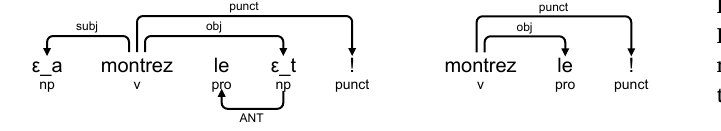
Figure 6: Dependency graphs representing the syntax of the sentence